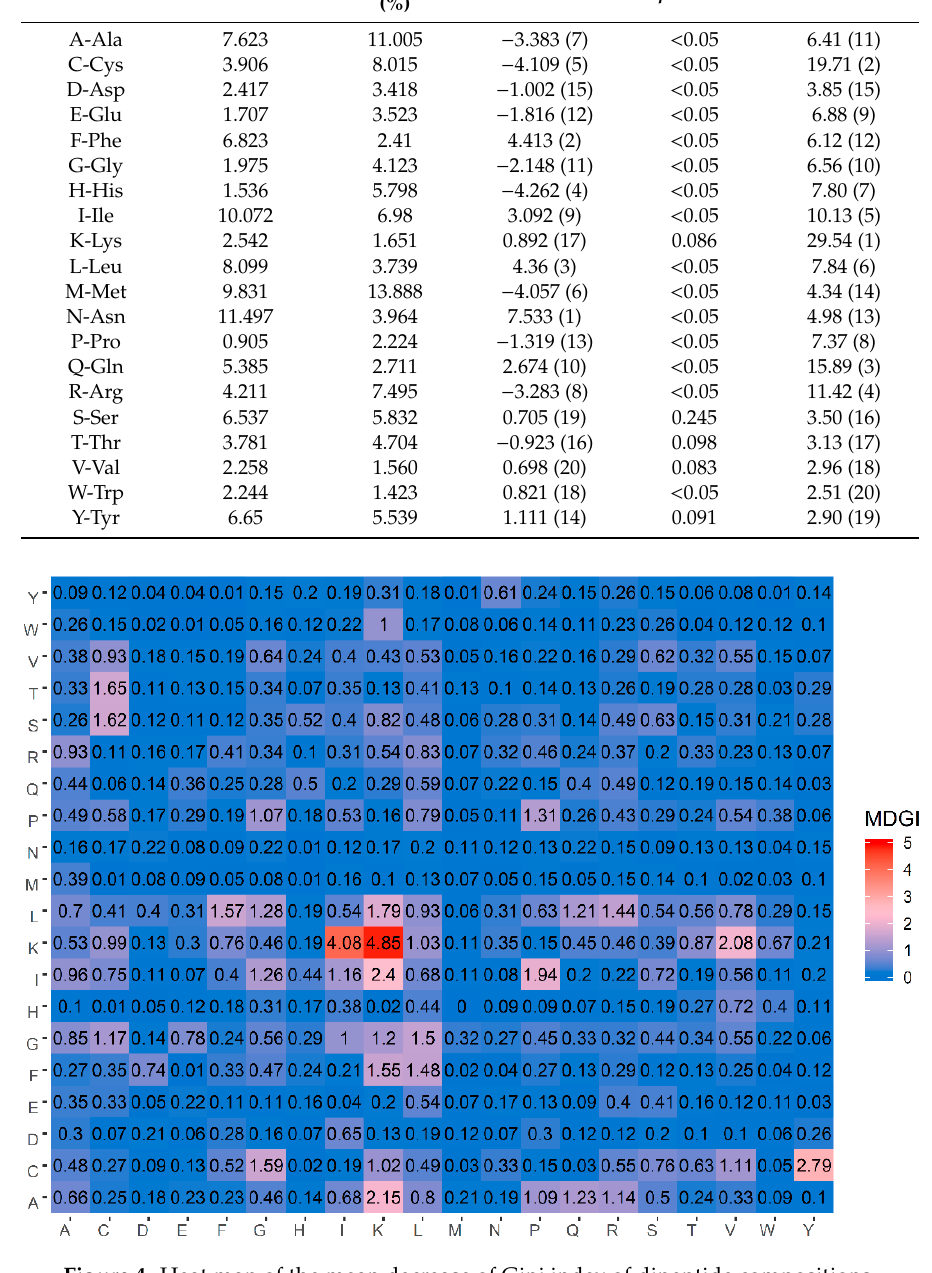
Figure 4. Heat map of the mean decrease of Gini index of dipeptide compositions.